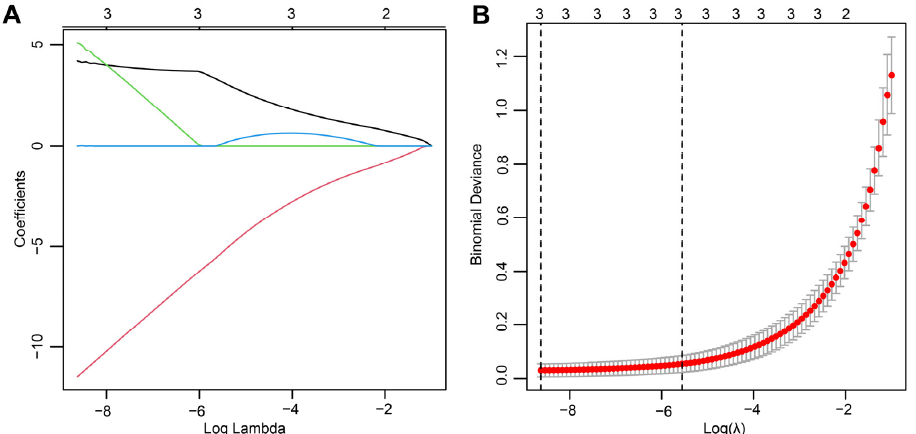
Figure 4. The final hub genes were identified by LASSO regression analysis. ( A ) Path diagram of the LASSO coefficients for the three hub genes in SAP. Each curve represents the trajectory of each hub gene, the vertical coordinate is the value of the gene, the lower horizontal coordinate is log( λ ), and the upper horizontal coordinate is the number of non-zero hub genes in the model at this time. ( B ) LASSO regression cross-validation curve. Optimal λ values were determined using 10-fold cross-validation.